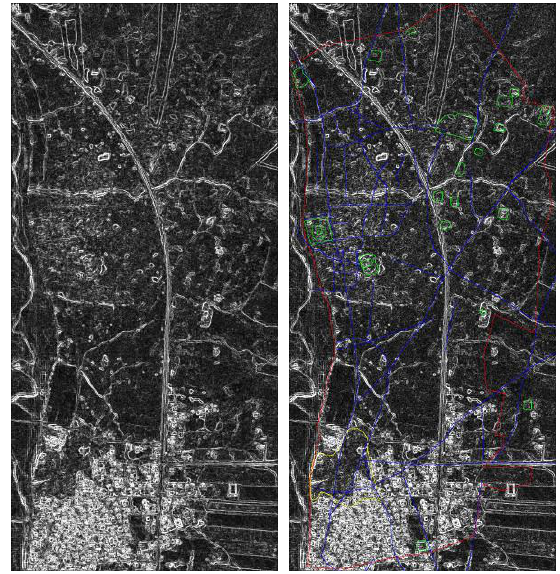
Figure 7 - A Sobel edge detector used on FORMOSAT-2 image of Al-Hadítha (acquired on 24. 10. 2014) with an overlaid objects of interest on the right picture.